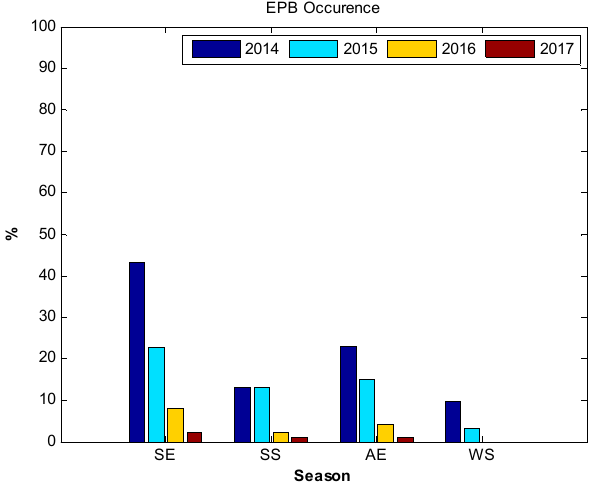
Figure 3. The seasonal plasma bubble occurrence during each year from 2014 to 2017. SE, SS, AE, and WS represent the spring equinox, summer solstice, autumn equinox, and winter solstice, respectively.